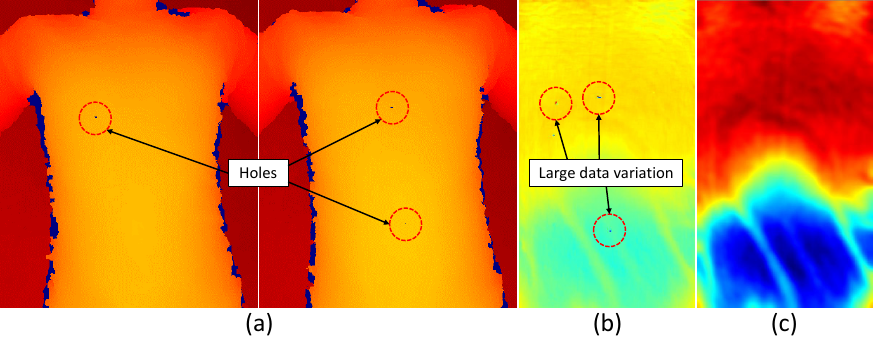
Figure 4. ( a ) Two example depth frames where holes appear in the chest wall region; ( b ) erroneous PCA result (eigenvector) where large data variations appear near the hole regions; ( c ) PCA result after applying hole-filling and bilateral filtering to input depth